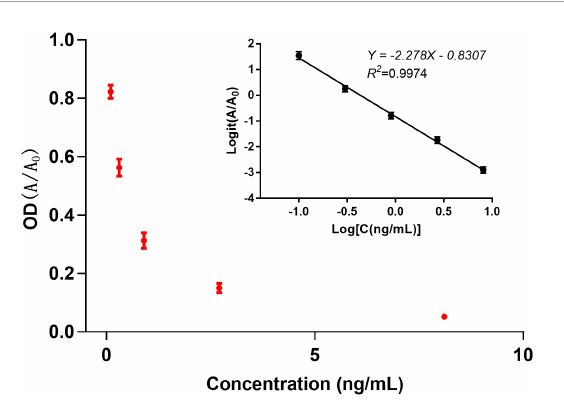
FIGURE2 Indirect competitive inhibition curve of the anti-aldicarb monoclonal